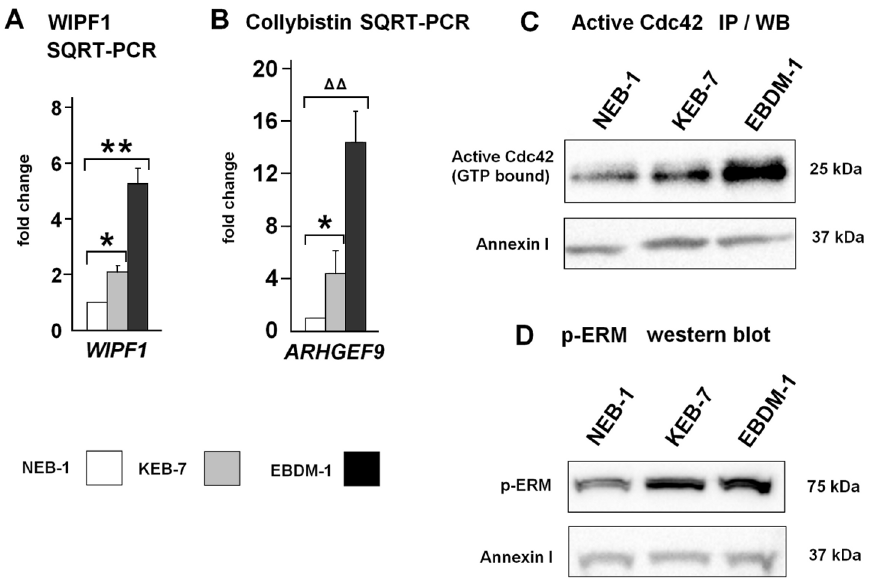
Figure 3. Aberrant regulation of actin cytoskeleton components. A. SQRT-PCR shows increased WIPF1 mRNA expression in KEB-7 and EBDM- 1 cell lines compared to NEB-1 wild-type keratinocytes (n=3). B. SQRT-PCR shows increased ARHGEF9 mRNA expression in KEB-7 and EBDM-1 cell lines compared to NEB-1 wild-type keratinocytes (n=5). C. Immunoprecipitation and western blot show increased amounts of active (GTP-bound) Cdc42 protein in KEB-7 and EBDM-1. Annexin-I was used as a loading control. D. Western blot of whole-cell lysates shows increased amounts of phospho-ERM proteins in KEB-7 and EBDM-1. Annexin-I was used as a loading control. Student’s t -test was performed with p values: * # 0.05, ** # 0.01, DD # 0.0005.